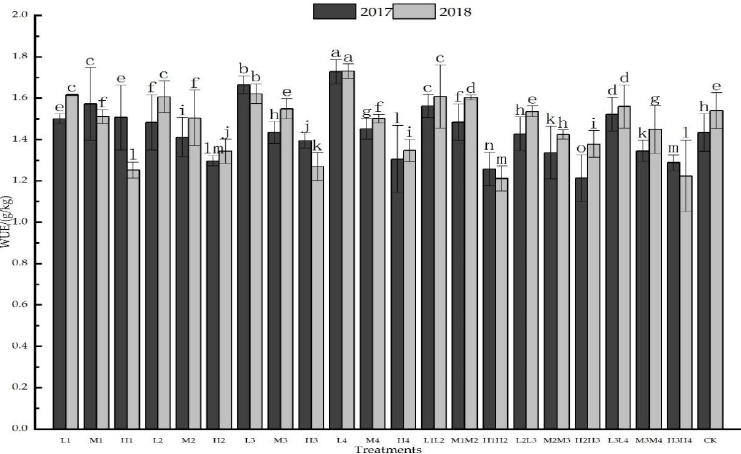
Figure 4. WUE of different treatments in 2017 and 2018. Different lowercase letters represent significant levels of each column at p ≤ 0.05. L: light water deficit, M: medium water deficit, H: severe water deficit. The number “1”, “2”, “3” and “4” represent the tillering, jointing and booting, flowering, and milk ripening stages,